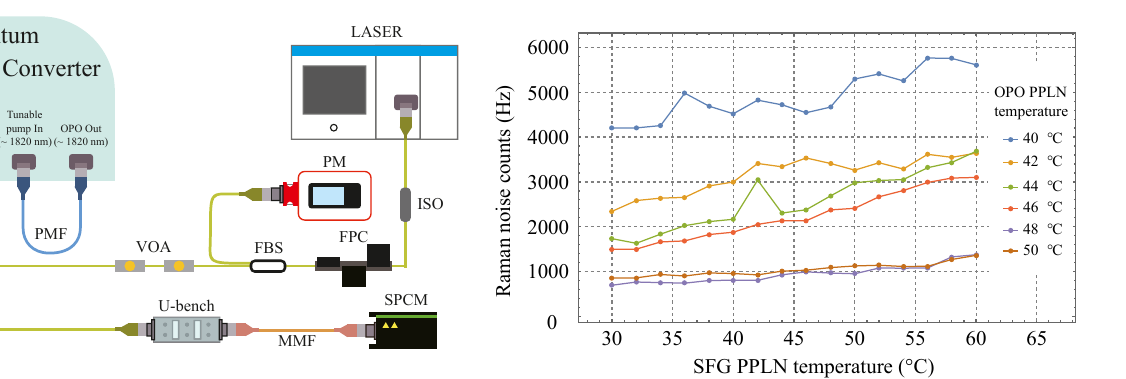
Figure 5: The schematic diagram of the optical setup for up-conversion single-photon detector (UCSPD) performance test using an attenuated laser. VOA: variable optical attenuator, SPCM: Si single-photon counting module.